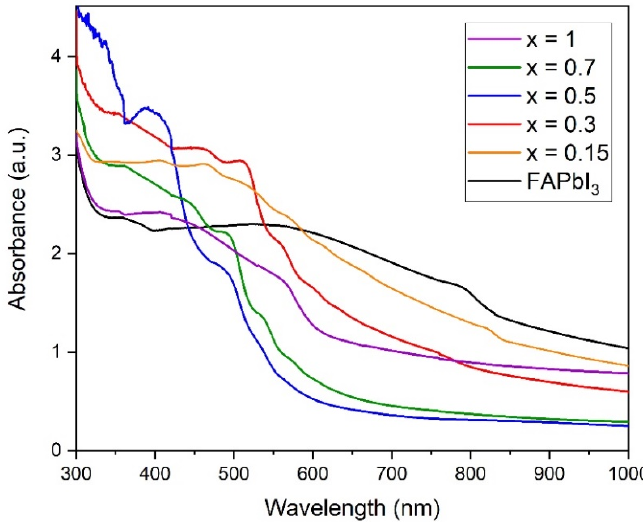
Figure 3. Absorbance spectra of the FAPbI 3 and FA 0.8 Cs 0.2 PbI 3 − x Br x perovskite layers.